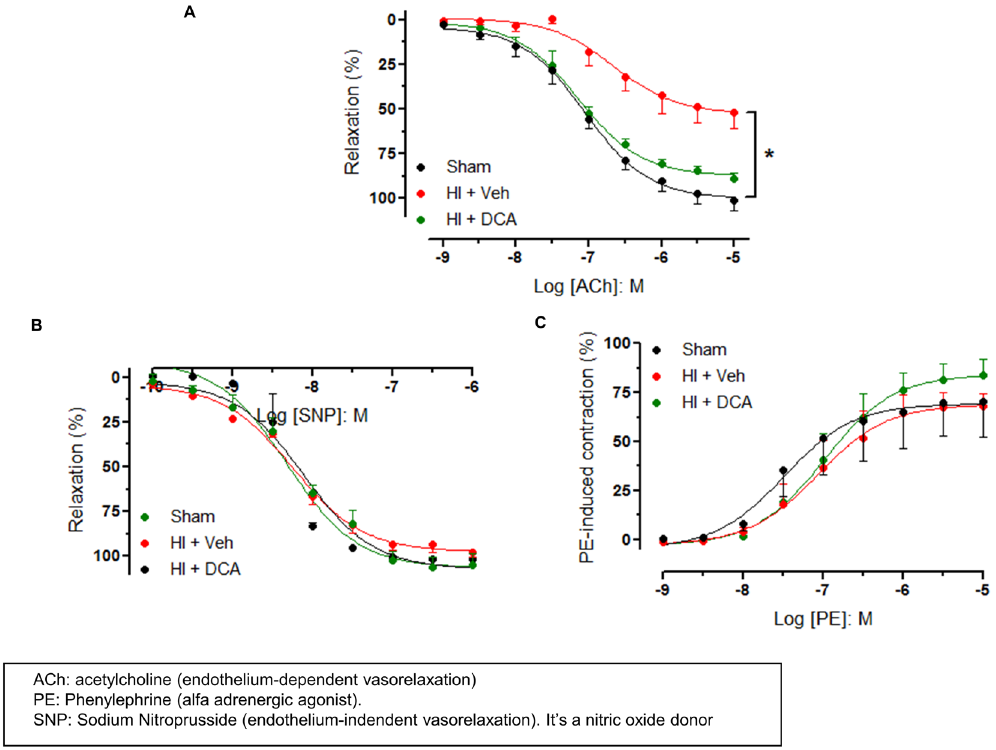
Figure 7. Impairment of endothelium-dependent vasorelaxation in rat aortas. ( A ) Concentration-response curves to ACh (0.001–10 µ M), ( B ) sodium nitroprusside (SNP; 0.0001–10 µ M), ( C ) and phenylephrine (PE, 0.001–10 µ M). Data represent the means ± SEM. n = 5 experiments. * p < 0.05 compared to control